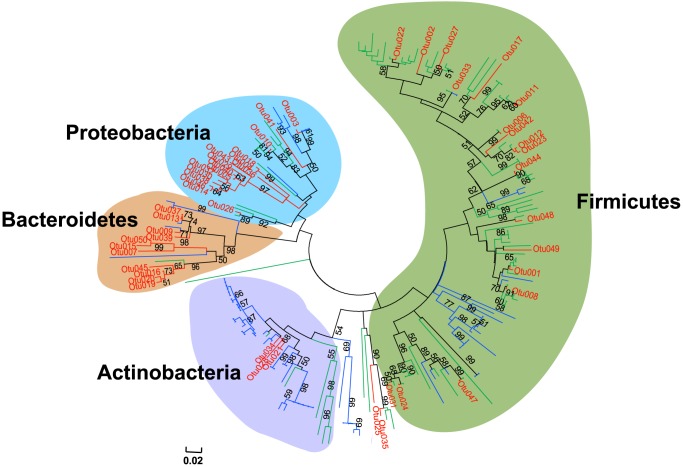
Neighbor-joining tree showing the phylogenetic relationship among the top 50 OTUs in this study (red) with known cellulose degraders (blue) and OTUs identified in the giant panda (green).Different phyla were shaded by different colors: green, Firmicutes; purple, Actinobacteria; orange, Bacteroidetes; blue, Proteobacteria. All bootstrap values > 50% were shown on the tree.